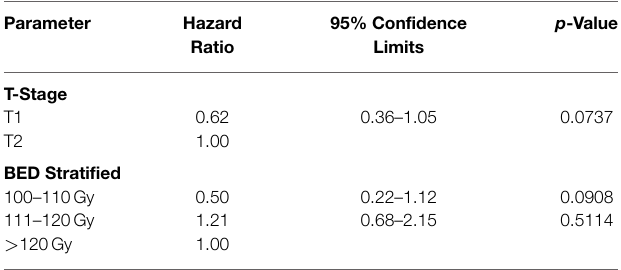
TABLE 4 | Multivariate analysis .